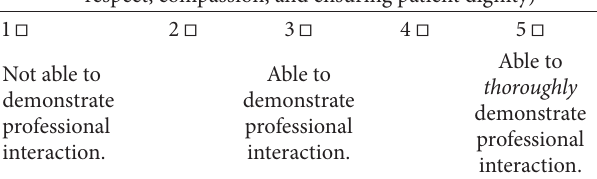
Table 2: Professional behaviour global rating scale for PSEs. Based on your observation of the student’s performance at this station, please complete the following global rating scales for professional conduct, safety, and effectiveness as well as the overall global rating that indicates pass, fail, or pass with